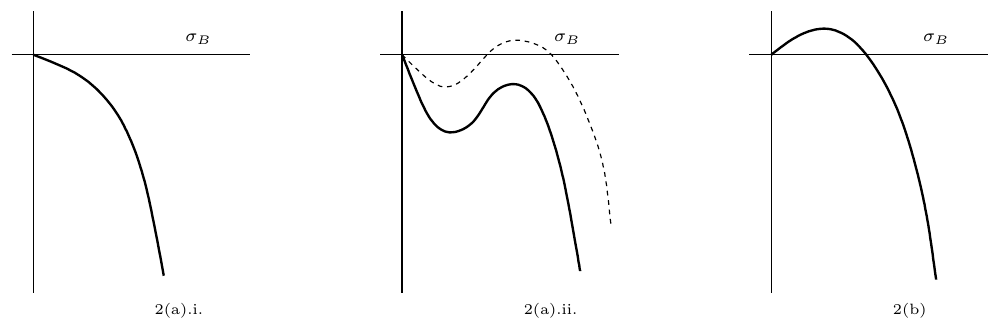
Figure 2 . E(cid:11)ective potential in the Higgsed phase for A h negative. (b) m 2 is positive : for either sign of B B